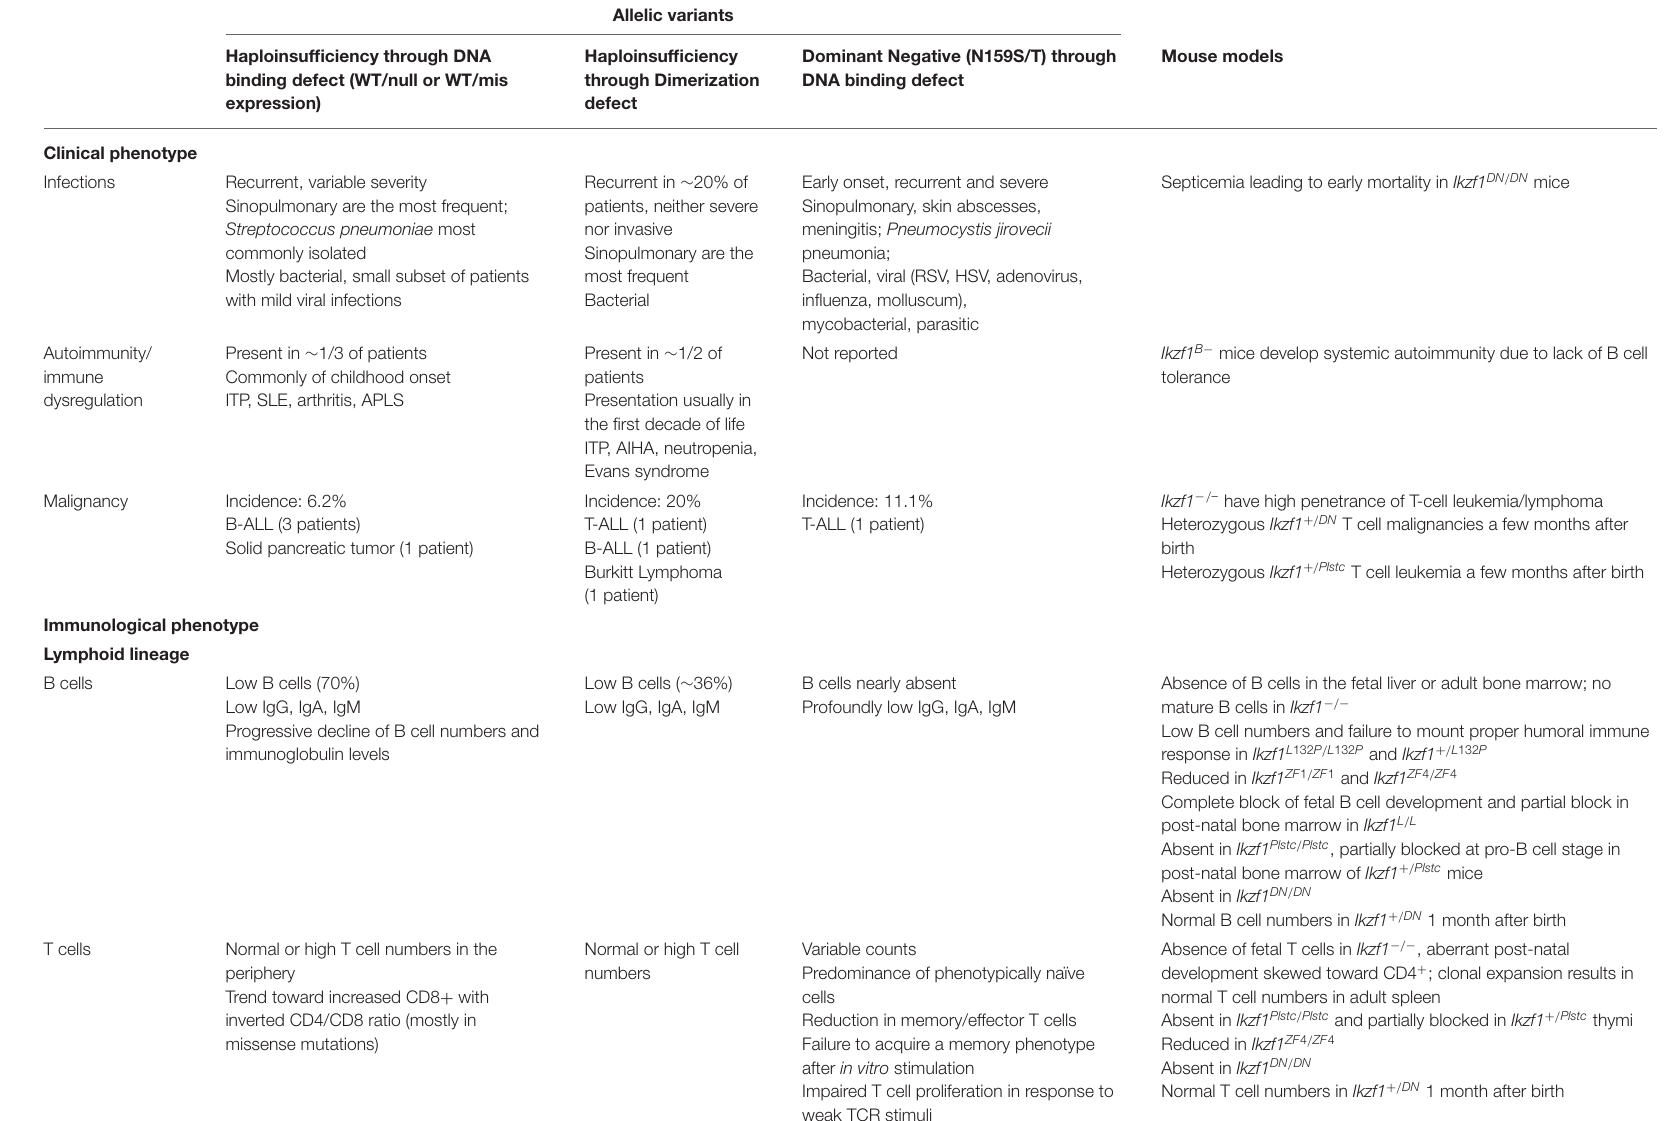
TABLE 1 | Key findings of heterozygous IKZF1 germline mutations in human disease and corresponding mouse models.